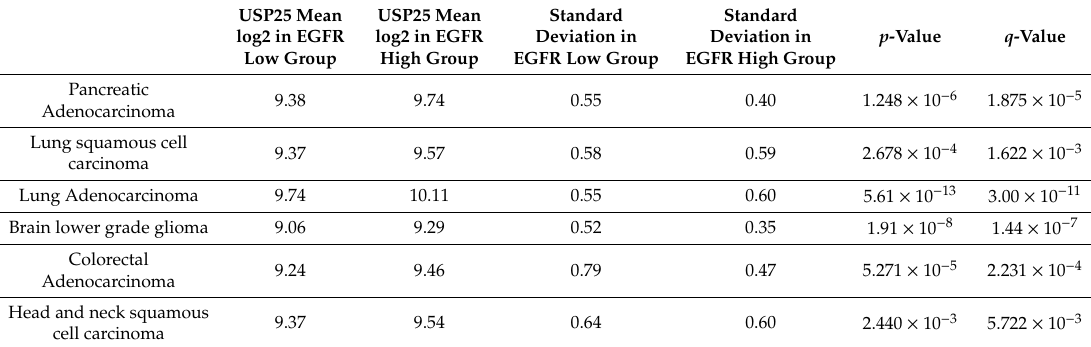
Table 1. Data obtained from the TCGA Cohort’s